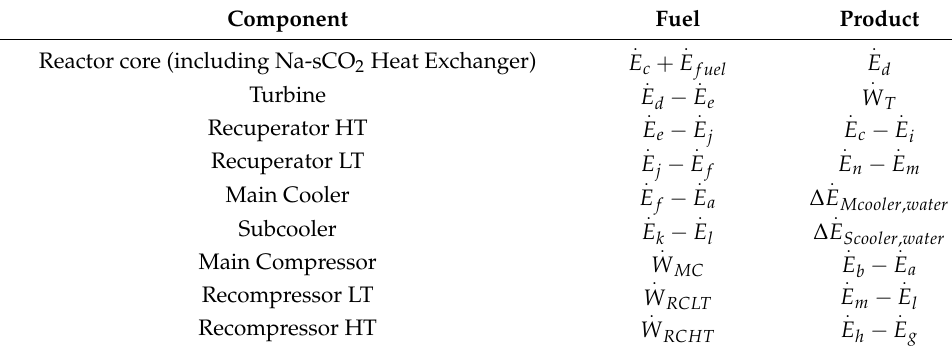
Table 2. Fuel–product definition of the partial-cooling cycle.